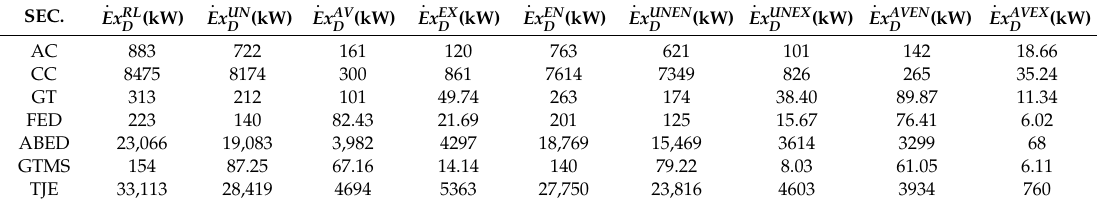
Table A6. Results for endogenous, exogenous, unavoidable and avoidable exergy demolition of TJE and sections in advanced exergy evaluation for the AB process mode for H 2 utilization